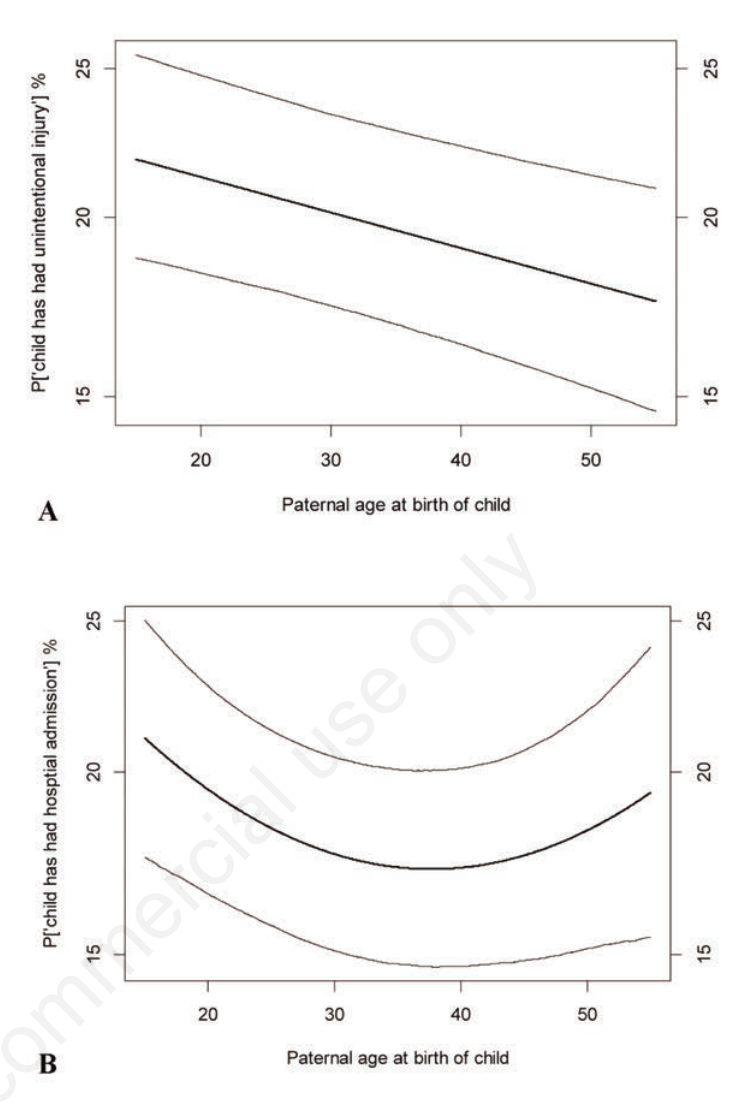
Figure 2. Regression line with 95% confidence interval for the final model of the out- come variable Child has had unintentional injury (A) or hospital admission (B) in